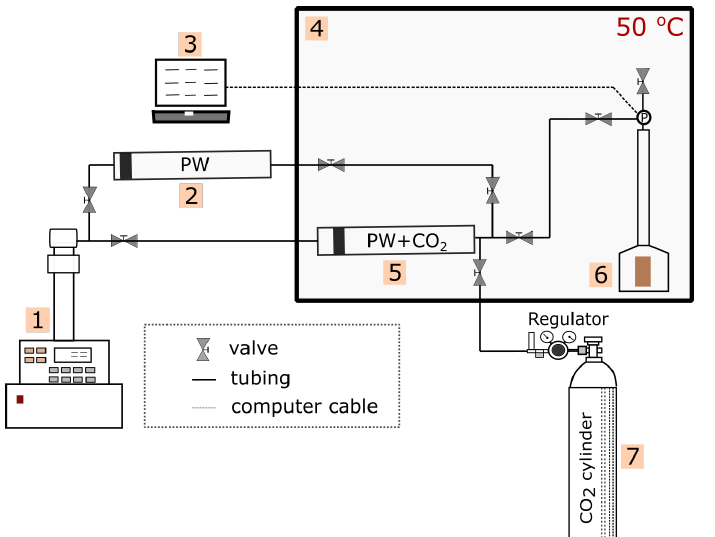
Figure 1. Experimental set-up for spontaneous imbibition with carbonated water (produced water with CO 2 : 1—Teledyne ISCO pump, 2—piston#2, 3—computer, 4—oven, 5—piston#3, 6—Amott cell with core plug, 7—CO 2